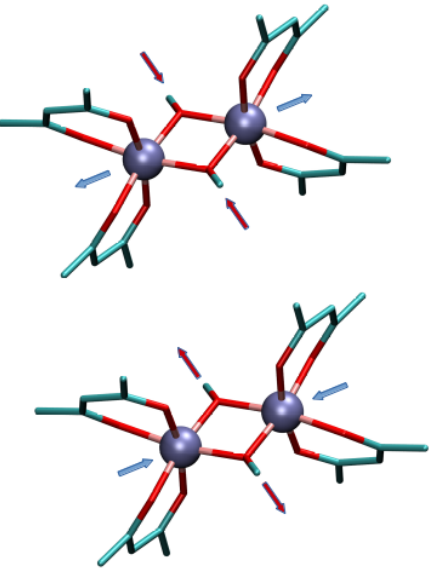
Figure 3. Scheme of the cartesian displacements corresponding to the normal mode q. Fe, O and C atoms are blue, red and green colored, respectively. H atoms are here not shown for clarity reasons. As expected, the J 12 value nicely correlates with the FeOFe angle and the reduced value calculated for the optimised geometry is fully accountable to the reduction of the FeOFe during the optimisation. Indeed, according to the plot reported in Figure 4, for the experimental FeOFe value of 102.7 ◦ the expected J 12 would be ∼ 5.5 cm − 1 , in good agreement with the calculation done on the 1-Ph xray model.